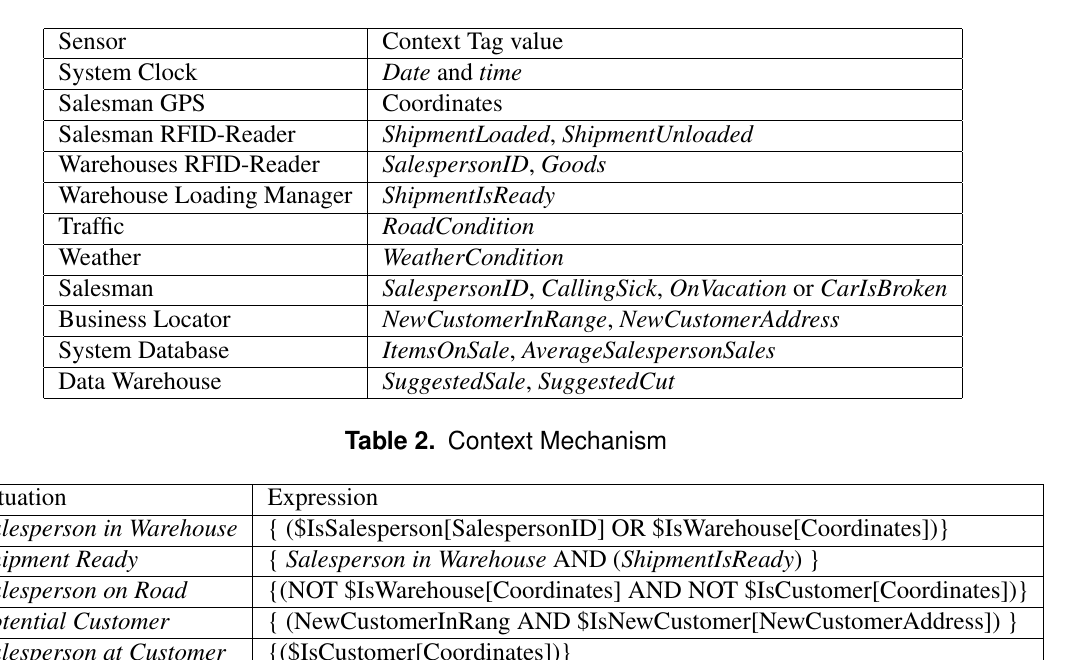
Table 1. Sensor Mechanism